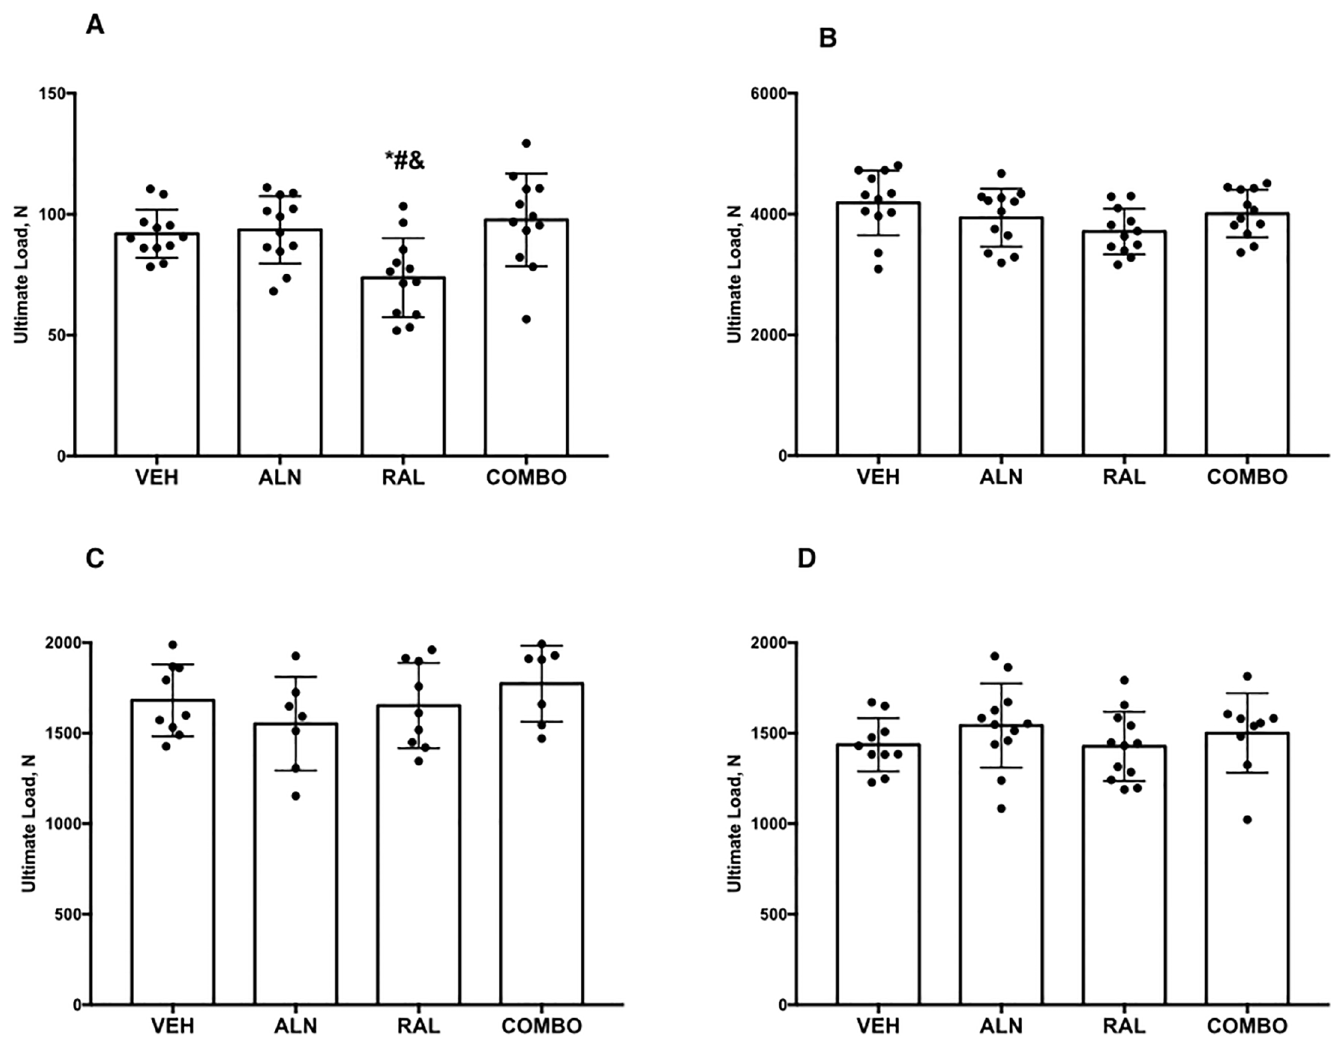
Fig 3. Whole bone ultimate load from the (A) rib, (B) vertebrae,(C) femoral neck and (D) femoral diaphysis. p < 0.05 vs ( * ) VEH, (#) ALN, (&) Combo.